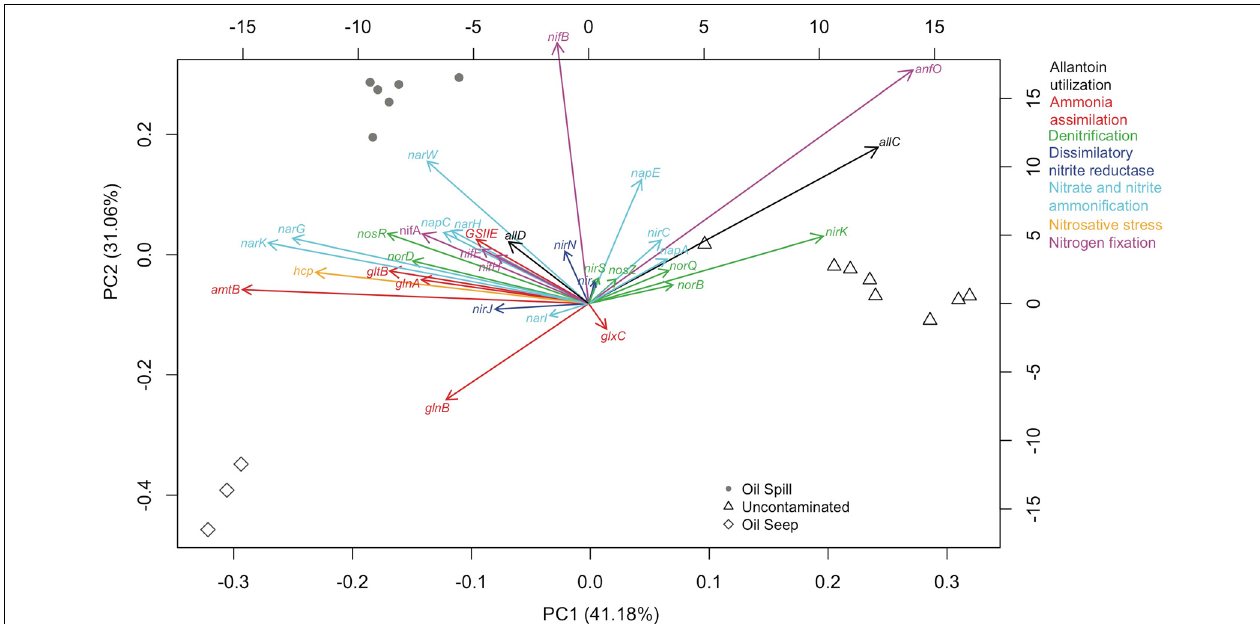
FIGURE 2 | Principal Components Analysis (PCA) of the relative abundance of nitrogen pathway gene annotation shared (33 genes) between the three samples types [oil spill (circles), oil seep (diamonds), and uncontaminated (triangles)]. Genes on the graph are given abbreviated names, but their full names and associated functional groups are given in